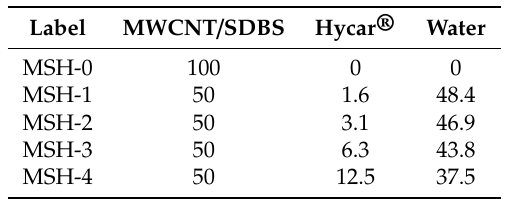
Table 1. Labels and compositions (vol. %) of multi-walled carbon nanotube (MWCNT) liquid inks. Ratios refer to the three liquid components, namely, the MWCNT / sodium dodecylbenzenesulfonate (SDBS) dispersion (8 and 5 mg · mL − 1 , respectively, in water), commercial acrylic additive, and extra added water.